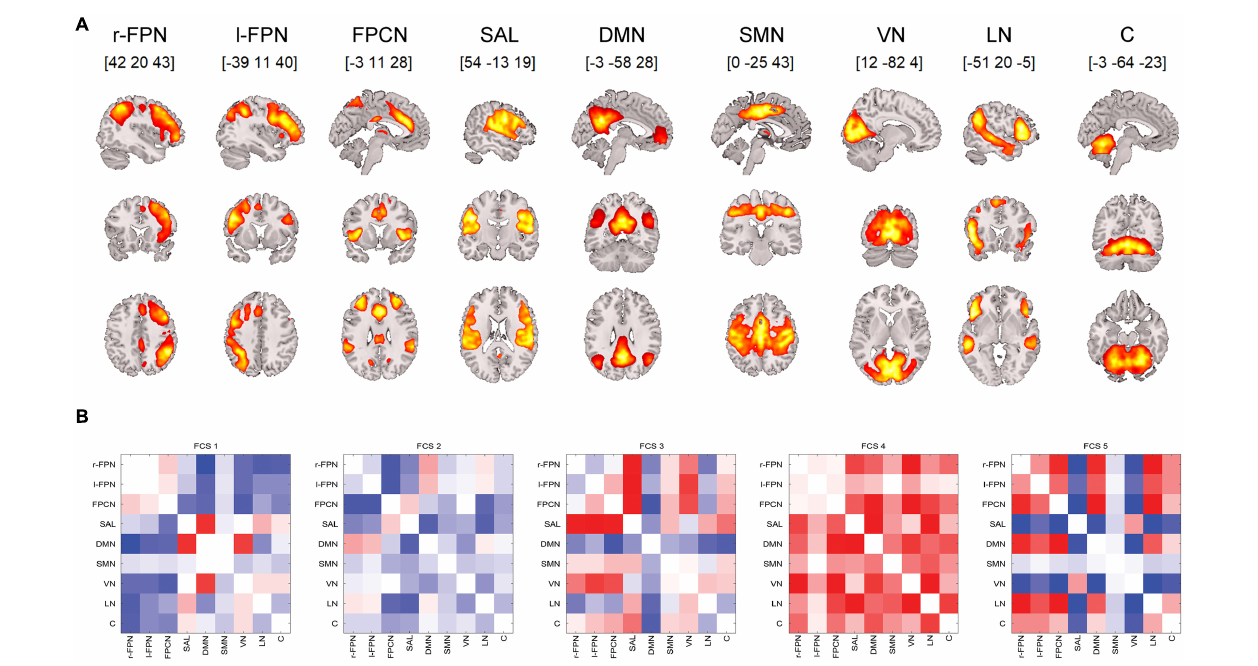
FIGURE 1 | (A) Nine ICA components analyzed for the resting-state dynamic functional connectivity. (B) Five identified rs-dFC states (1–5 from the left). Each matrix depicts mutual correlations between each component identified using the ICA. Dark blue suggests a high negative correlation, and dark red suggests a high positive correlation. Note: rs-dFC, resting state dynamic functional connectivity states; r/l-FPN, right/left frontoparietal network; FPCN, frontoparietal control network; SAL, salience (insulo-opercular) network; DMN, default-mode network; SMN, sensorimotor network; VN, visual network; LN, language network; C,